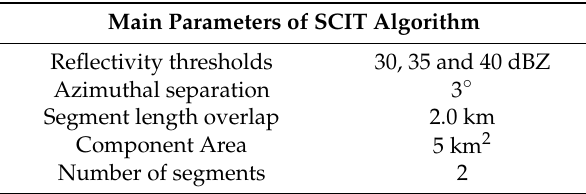
Table 3. Key-parameter settings of Storm Cell Identification and Tracking (SCIT) algorithm. A detailed description of the listed parameters can be found in